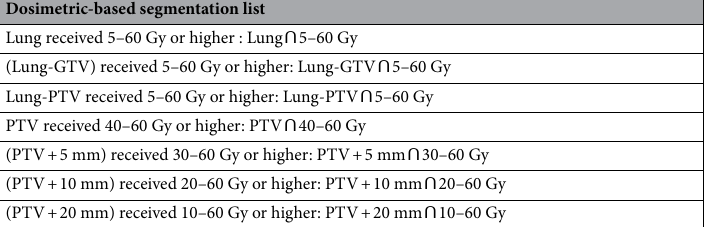
Table 2. Dosimetric-based segmentation list in multi-region radiomics analysis. “ROI ∩ XX Gy” indicated